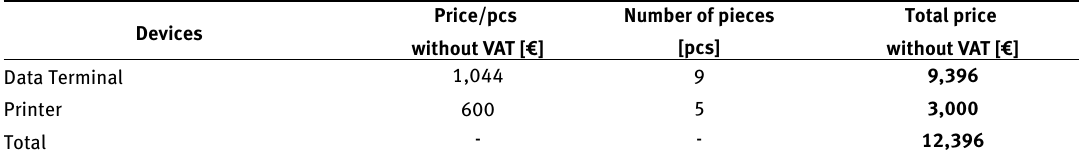
Table 3: Beta manufacturer devices and their parameters Devices